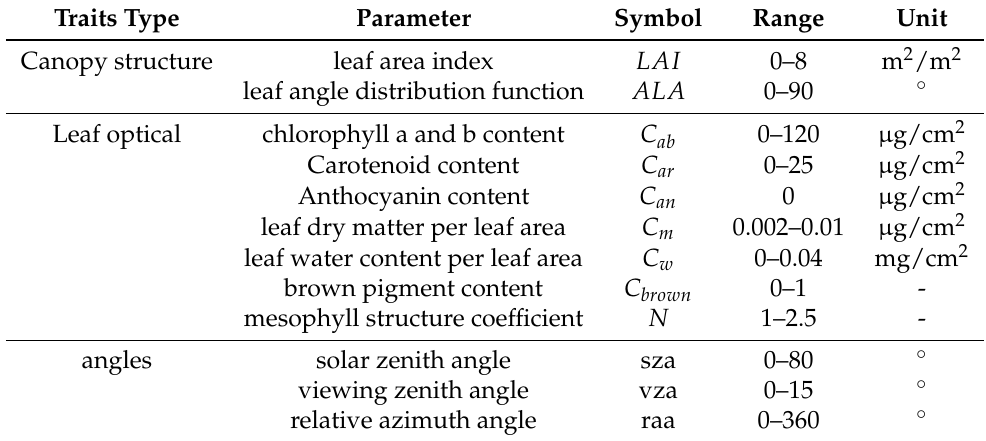
Table A2. List of PROSAIL parameters used along with the APSIM-maize model in the study.